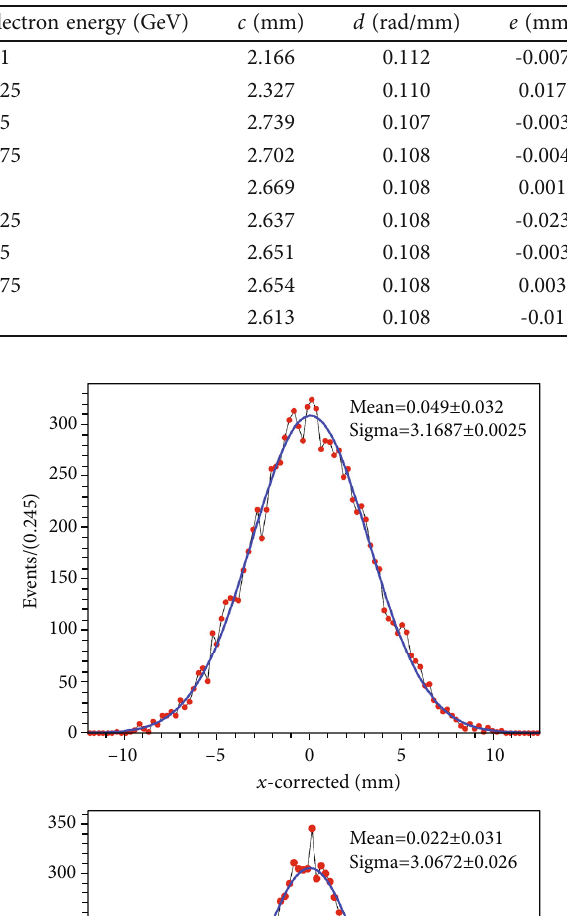
Table 1: Fit parameters for the incident electrons in the X